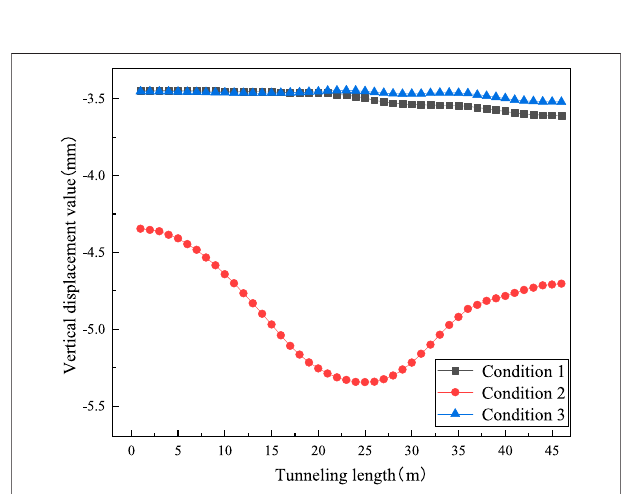
FIGURE15| Surfacesettlementcurvediagramatdifferentsectionsofthetunnel. (A) SurfacesubsidencecurvediagramatsectionI-I. (B) Surfacesubsidencecurve diagram at section II-II.